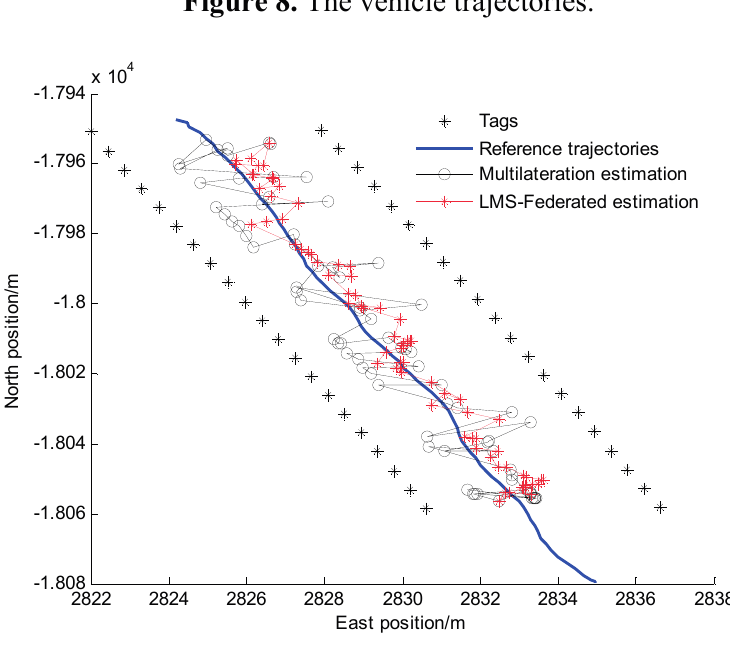
Figure 8. The vehicle